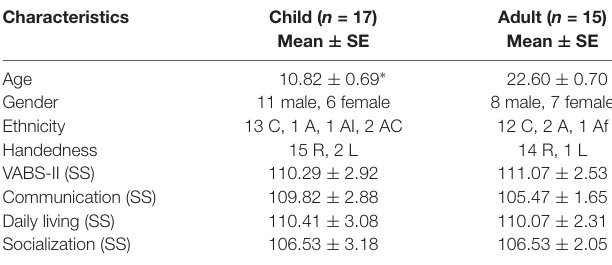
TABLE 1 | Demographic and developmental/cognitive data.